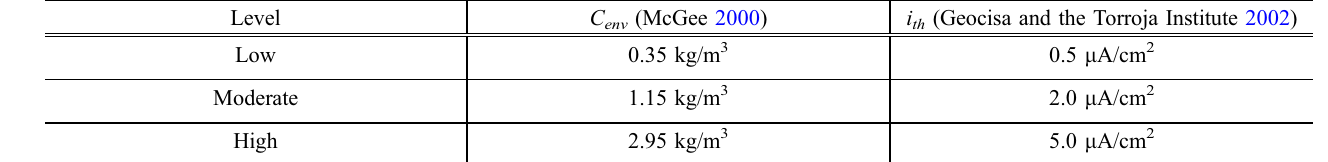
Table 5 Aggressiveness levels.